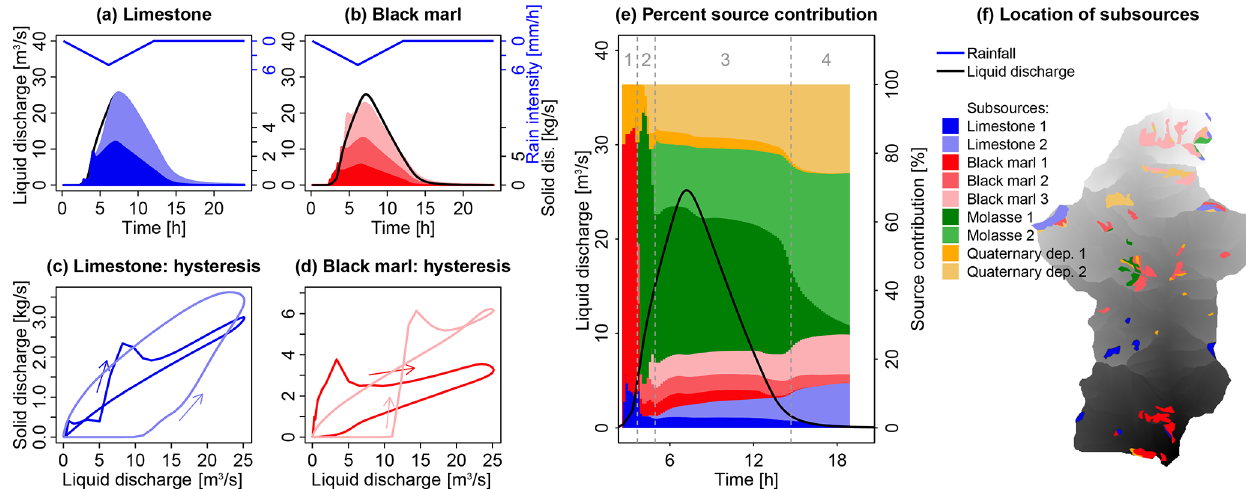
Figure 10. (a, b) Contribution of subsources of limestone and black marl that are classified according to their distance to the outlet (Sc. 4a). The colored areas show the contribution of sources close to the outlet (darker colors) and more distant sources (lighter colors) from the sedigraph. (c, d) The hysteresis loops of the subsources. (e) The contribution of each subsource to total suspended solid discharge in percent. The dashed lines and the grey numbers above the figure distinguish different periods of the event as referred to in the text. (f) Location of the subsources in the Galabre catchment.